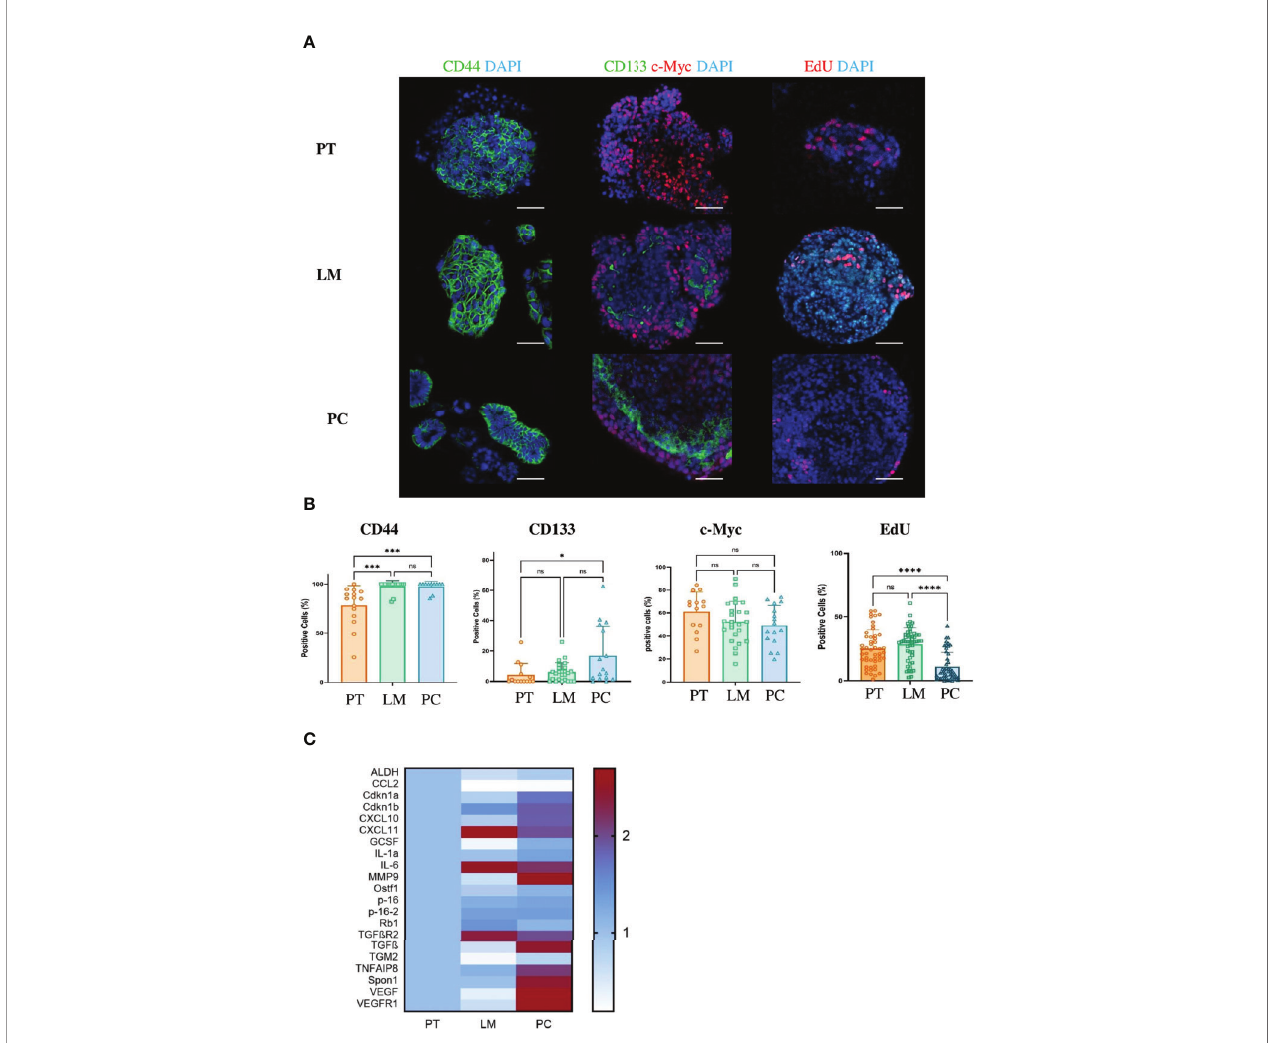
FIGURE 4 | Cancer cells from metastases in the peritoneal cavity of the APTAK mouse model show enhanced stem cell-like phenotype and a SASP. (A) Representative immuno fl uorescence (IF) images of the stem cell markers CD44, CD133 (green) and c-Myc (red) of tumor organoids derived from primary tumors (PT), liver metastases (LM) and PC from the orthotopic organoid transplantation CRC mouse model. The proliferation marker EdU stained in red and nuclei in blue. Scale bars represent 50 µm. (B) Quanti fi cation of IF markers from (A) . 5 HPF with at least 1000 cells from primary tumors (n = 5), liver metastases (n = 3) and PC (n = 3) were counted. Error bars represent the mean ± SD. Kruskal-Wallis test (B) ****p < 0.0001, ***p < 0.0002, *p < 0.05, n.s. = not signi fi cant. (C) Heatmap of characteristic SASP genes from tumor organoids derived from primary tumors (PT), liver metastases (LM) and PC (n = 3 mice per group) from the orthotopic organoid transplantation CRC mouse model. Tumors were isolated, dissociated and cultured for one passage as 3D organoids. Then mRNA was isolated and qPCR was